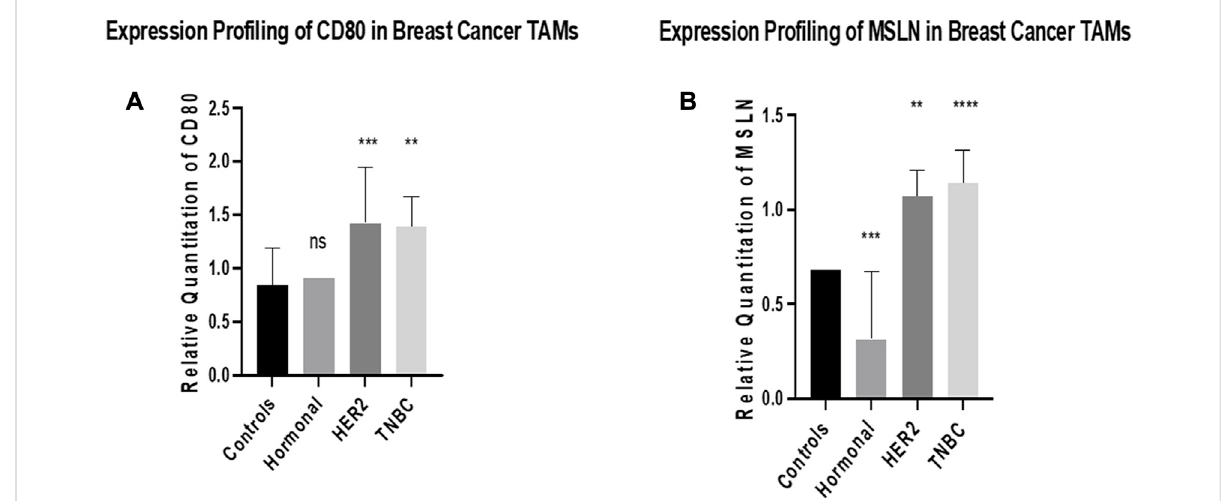
FIGURE 2 Expression pro fi ling of CD80 and MSLN in breast cancer TAMs. q-PCR was performed for the quantitative analysis and expression pro fi ling of theCD80andMSLNlevelsinTAMsofBCsubtypes(hormonal,HER2+,andTNBC)comparedtohealthydonors. (A) Resultsshowedanon-signi fi cant change in the expression pro fi le between TAMs of the hormonal subtype and healthy donors. Conversely, a signi fi cant upregulation of CD80 was observed inTAMs ofHER2+ and TNBC compared to healthydonors. (B) Expression ofMSLNshowed signi fi cantdownregulation inTAMs ofthe hormonal subtype compared to healthy donors. Conversely, a signi fi cant upregulation of MSLN was observed in TAMs of HER2+ and TNBC compared to healthy donors. One-way Anova followed by Dunette ’ s Test of multiple comparison was used for the purpose of comparison